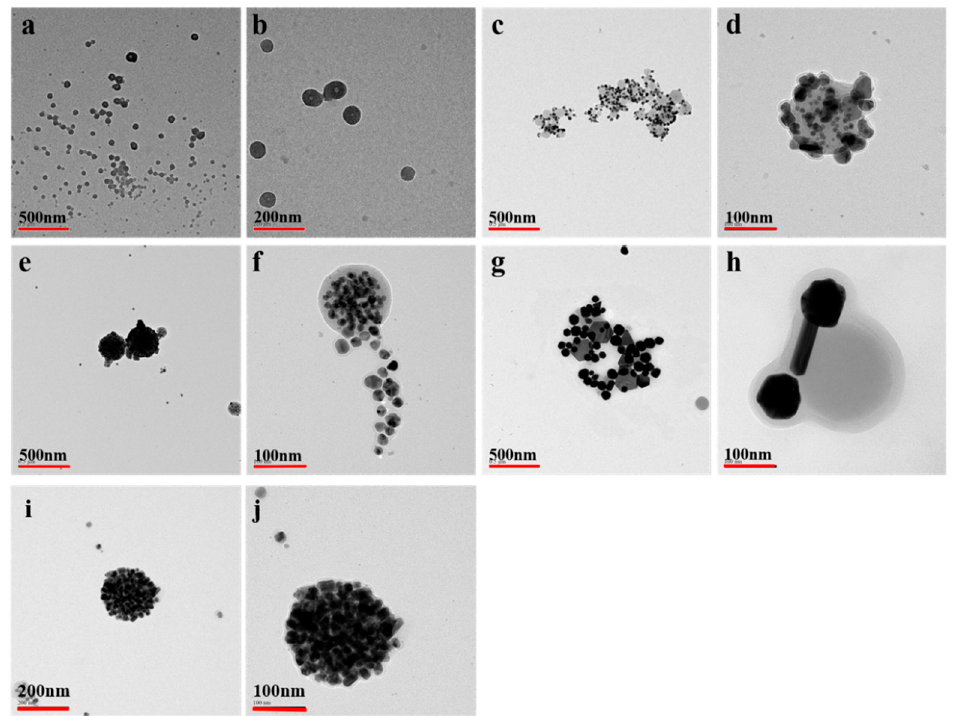
Figure 7. TEM of the LNPs ( a , b ), LNPs@AuNPs 1 ( c , d ), LNPs@AuNPs 2 ( e , f ), LNPs@AuNPs 3 ( g , h ), Au NPs@ LNPs 2 storage for seven days ( i , j ).